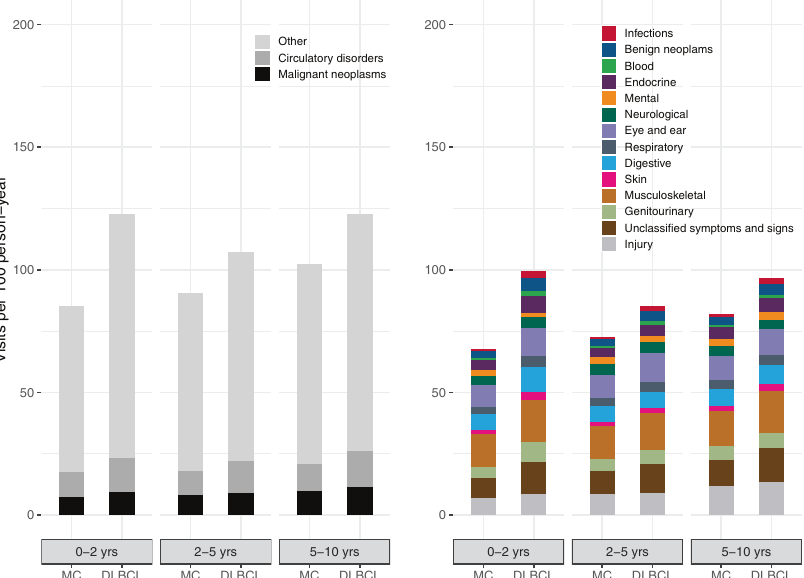
Fig. 3 Incidence rates of hospital outpatient specialist clinic visits strati fi ed by ICD-10 chapter among survivors and matched comparators in different time periods (0 – 2, 2 – 5, 5 – 10 years after the index date). The incidence rates of conditions included in the “ Other ” category in the left-hand panel are displayed in the right-hand panel. DLBCL diffuse large B-cell lymphoma, MC matched